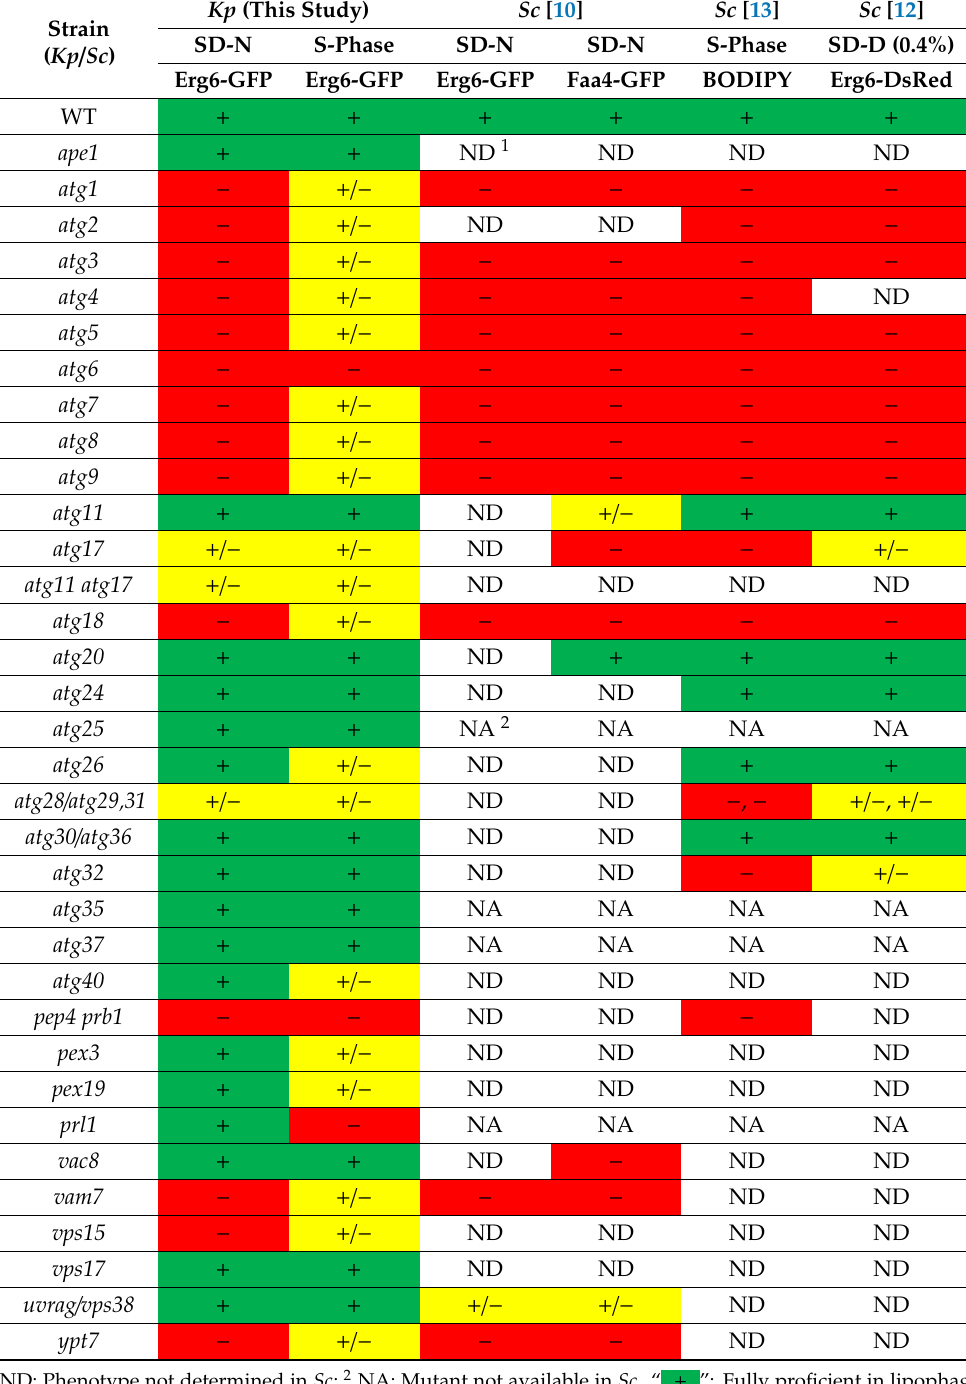
Table 2. Lipophagy phenotype of K. pha ffi i (this study) and S. cerevisiae